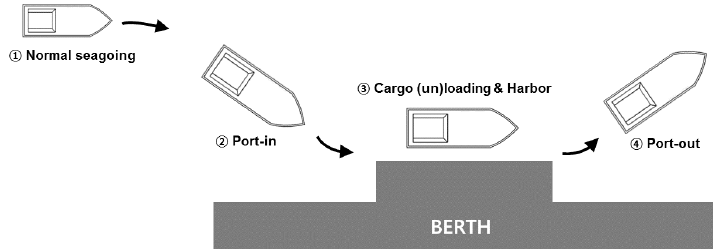
Figure 3. Docking / undocking procedure of a ship in a conventional system. Figure 3. Docking/undocking procedure of a ship in a conventional system.